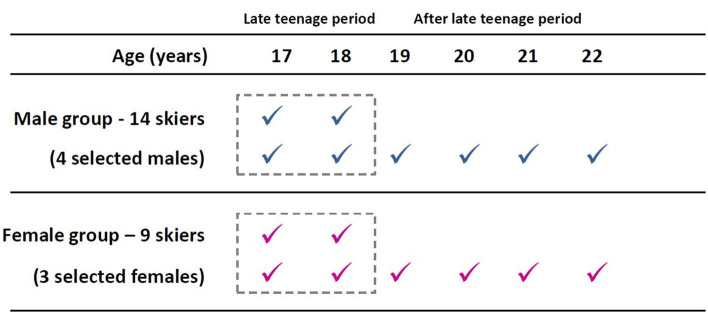
Visual overview of the longitudinal research. The figure shows the time-course of the tests yearly performed by male (blue) and female (purple) athletes. All the athletes performed two consecutive evaluations from 17 to 18 years of age, while only the selected athletes did six consecutive evaluations from 17 to 22 years of age. Late teenage (dotted-lined boxes) and after late teenage periods were here represented.